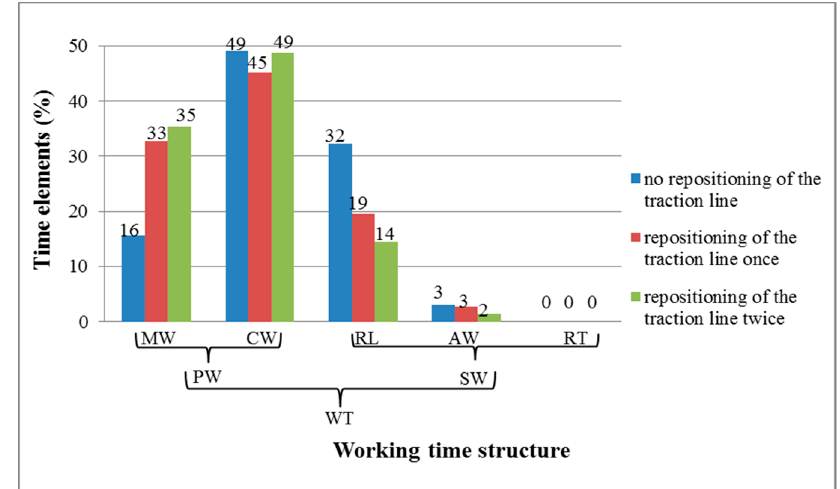
Figure 5. WT structure in the felling of hung up trees according to time elements: WT—working time; PW—productive working time; SW—supportive working time; MW—main working time; CW— complementary working time; RL—relocation time; AW—ancillary working time; RT—repair time.